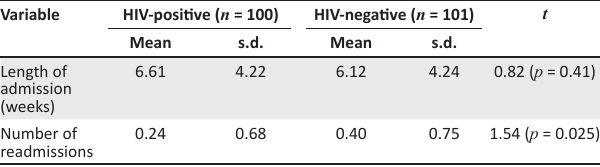
TABLE 3: Human immunodeficiency virus status, length of admission and number of readmissions.